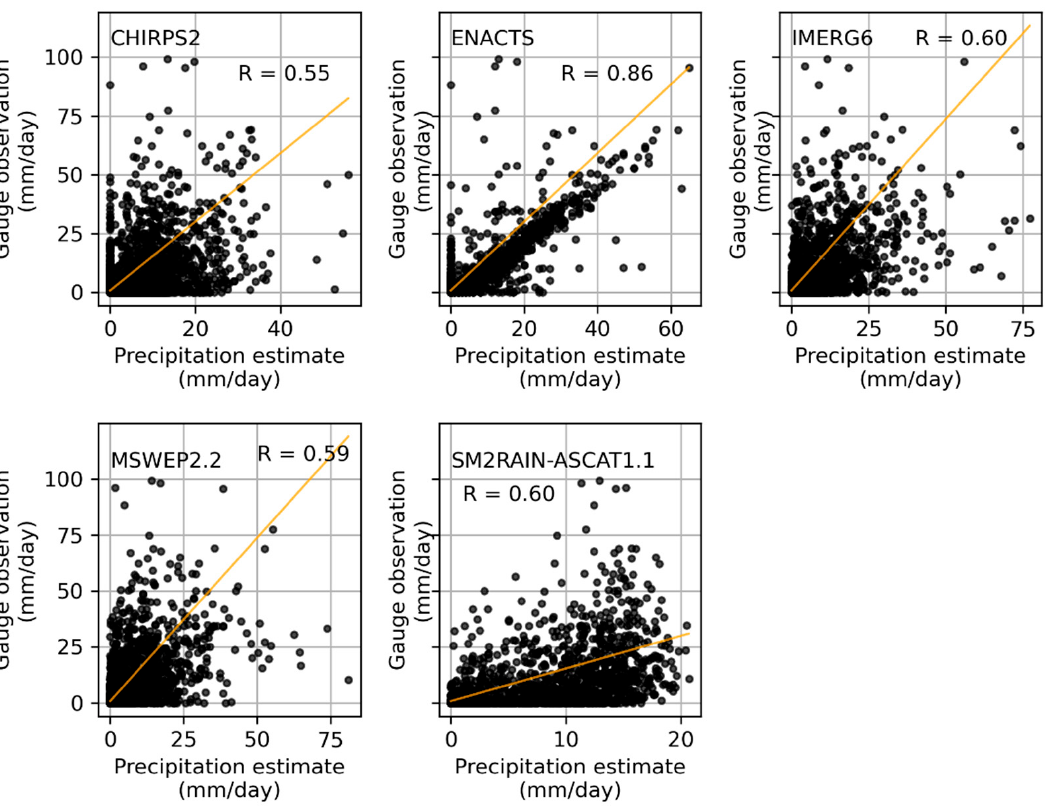
Figure 9. Scatter plots of rain gauge observations and precipitation dataset estimates at daily temporal scale over UBNRB.